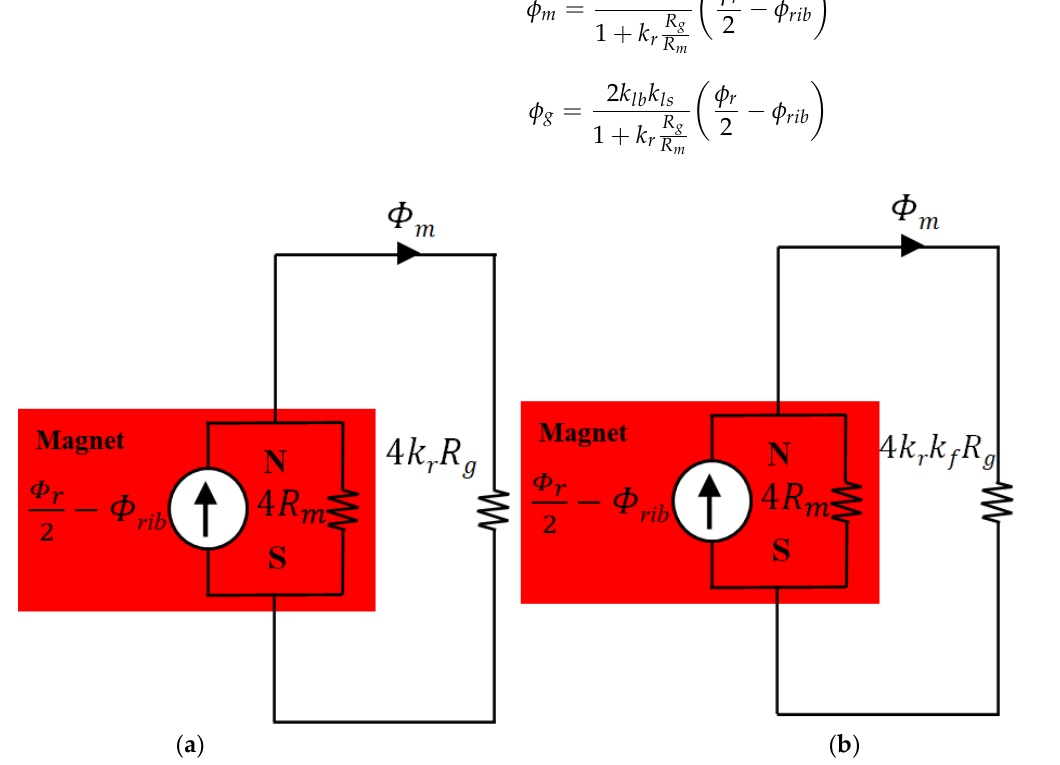
Figure 4. Simplification of magnetic circuit: (a) conventional model; (b) conventional model with ferrofluid.